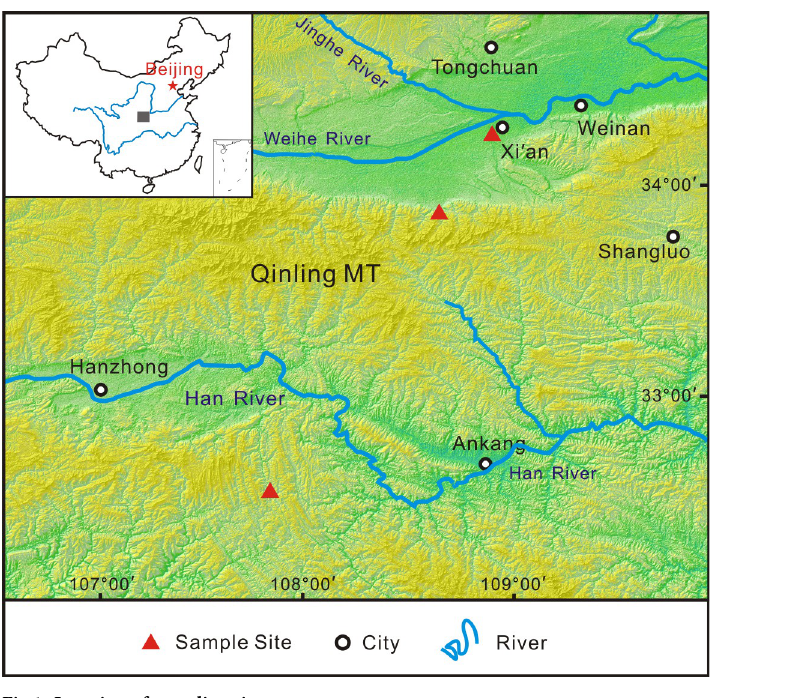
Fig 1. Location of sampling